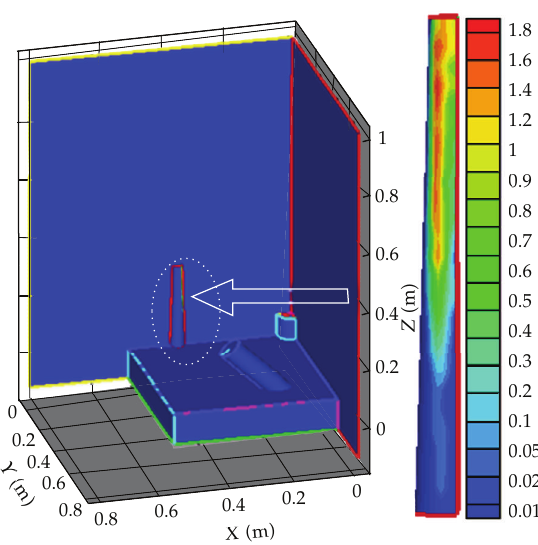
Figure 7: Sputtering depth for surface 1 (cid:2) μ m/200h (cid:3) .